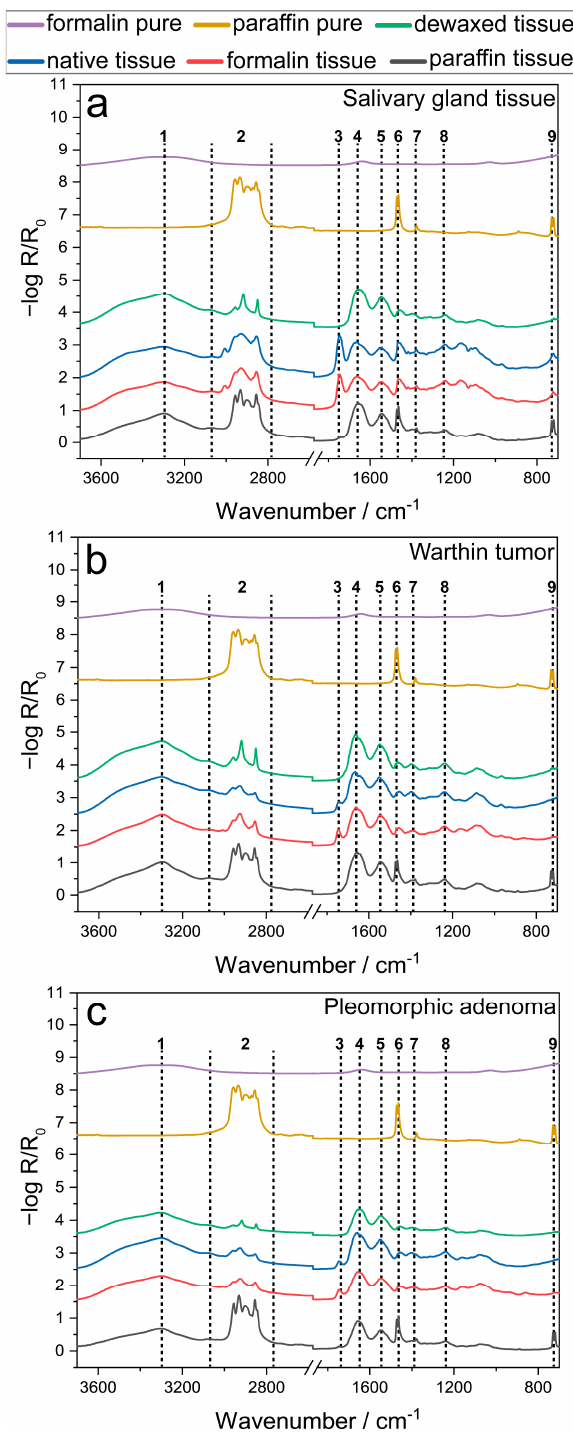
Figure 4. FTIR average spectra of each preservation method (“native” (blue), “formalin” (red), “in paraffin” (grey), “dewaxed” (green)) for the three investigated tissue types, salivary gland tissue ( a ), Warthin tumor ( b ) and pleomorphic adenoma ( c ). “Formalin pure” (purple) and “paraffin pure” (yellow) average spectra were additionally presented to reveal the IR oscillations resulting from the preparation chemicals. All average spectra are placed by an offset for an improved comparability of signals, also indicated by the dotted lines and numbers (1–9).